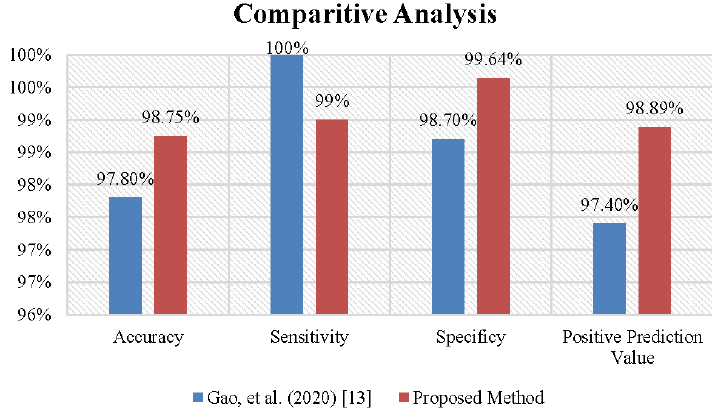
Figure 9: Comparative analysis of the proposed technique with latest state-of-the-art method